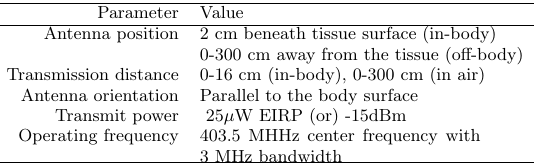
Table 1: Simulation parameters from IEEE